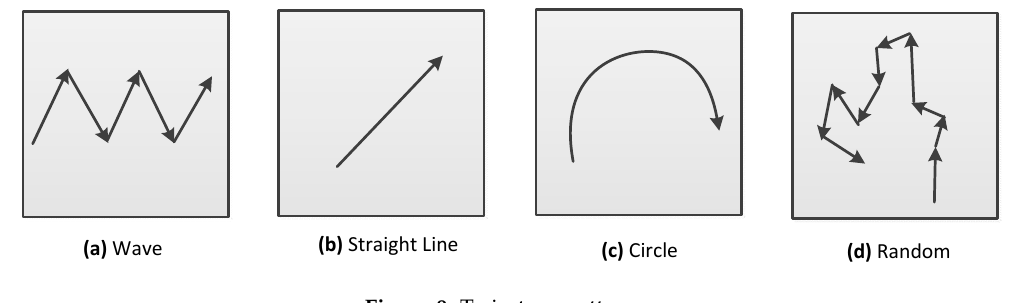
Figure 9. Trajectory patterns.